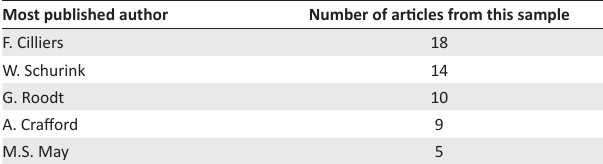
TABLE 5: Scholarly involvement (most published